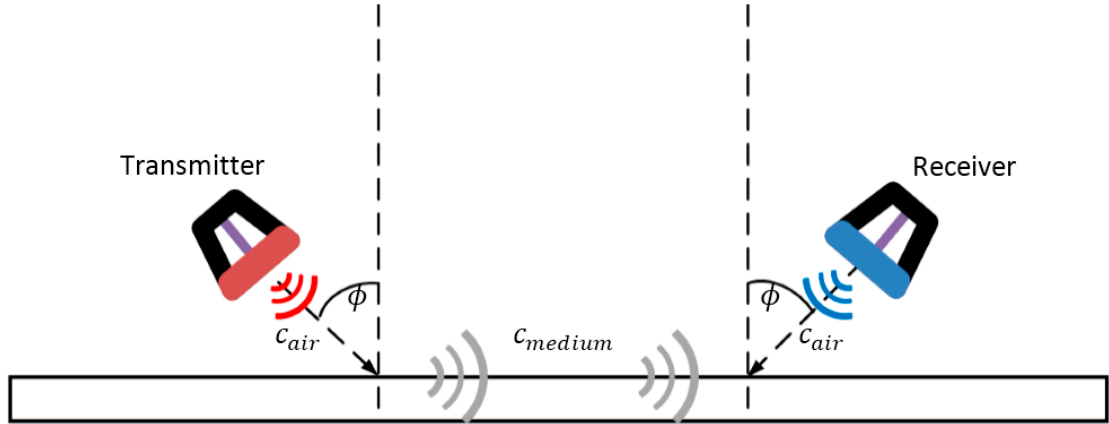
Figure 1. Schematic illustration of the use of Snell’s law to determine the incident and sensing angles of air-coupled transducers (ACTs) in the pitch-catch configuration.